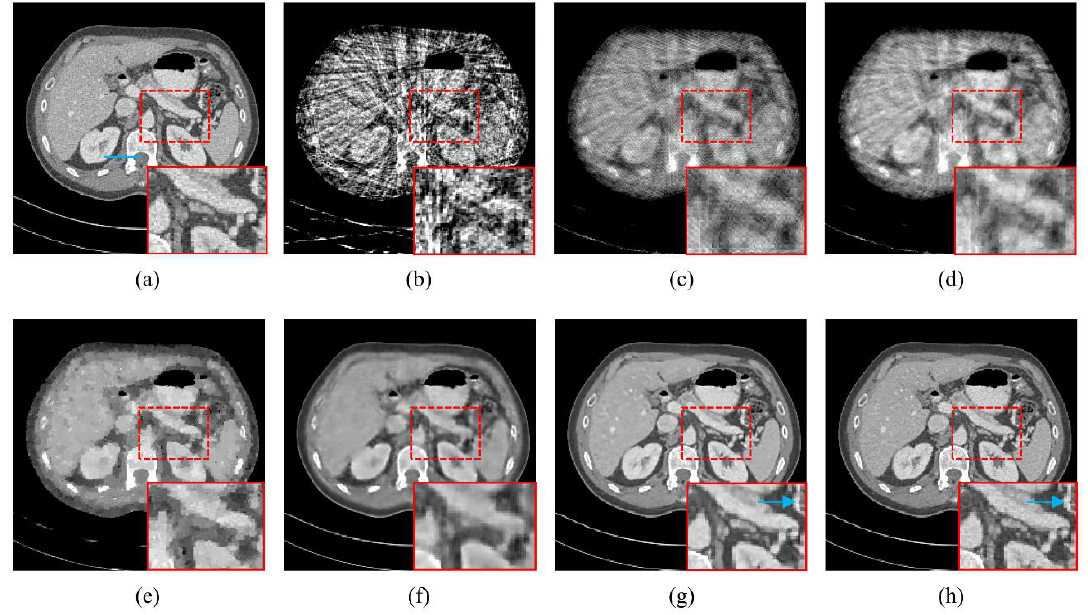
Figure 3. Images reconstructed (from 32 views) using various reconstruction methods. ( a ) The reference image versus the images reconstructed using ( b ) FBP, ( c ) ART, ( d ) ART-TV, ( e ) TVAL3, ( f ) FBPConvNet, ( g ) LEARN, and ( h ) our network. The profiles along the blue line are shown in Figure 4. The red box indicates the ROI, which is magnified. The display window is [ − 150, 250] HUs in